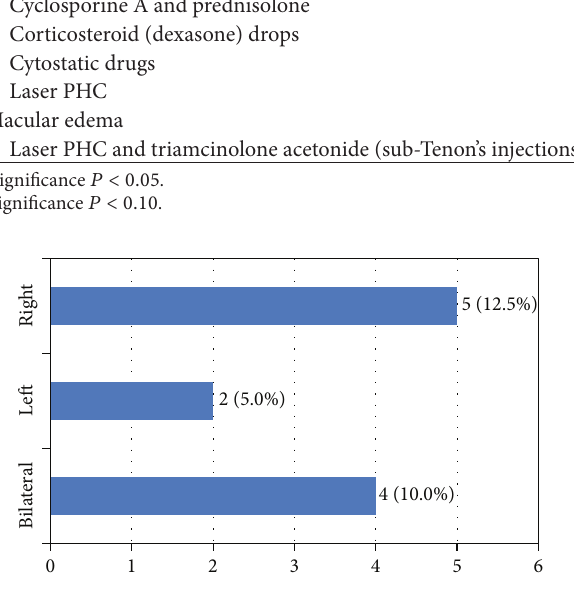
Figure 4: Average visual acuity before and after